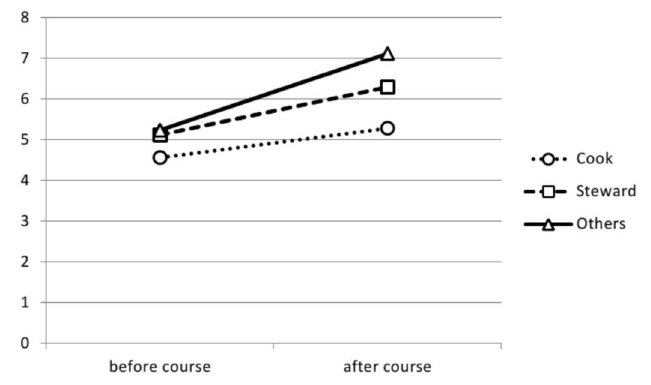
Figure 4. The level of participant knowledge of principles of nutrition before and after the course, taking position into account